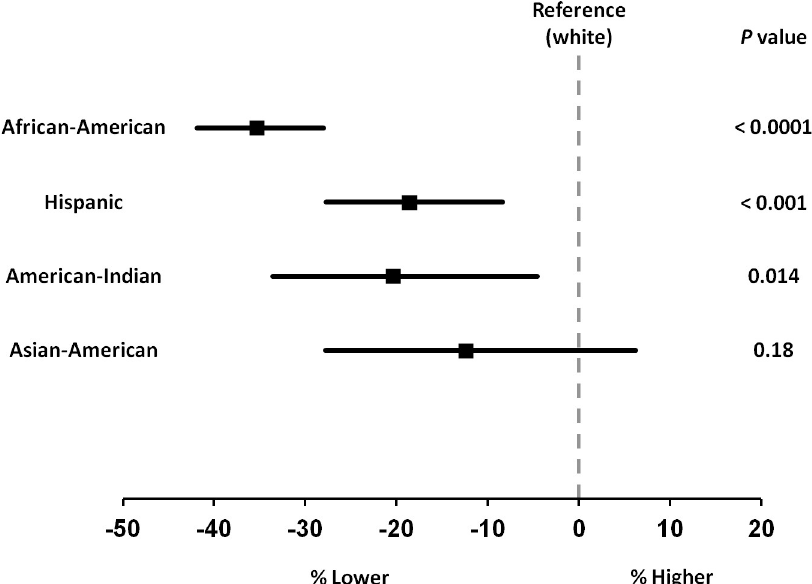
Fig 2. Multivariable adjusted percent differences in baseline NT-proBNP levels by race/ethnicity compared with white individuals in the DPP. Percent difference (95% confidence interval) in NT-proBNP by race/ethnicity compared with white individuals. Values calculated from multivariable linear regression adjusted for: age, gender, body mass index, systolic blood pressure, diastolic blood pressure, history of hypertension, insulin sensitivity, estimated glomerular filtration rate, education and income. ANCOVA P < .005 considered statistically significant to account for multiple comparisons.